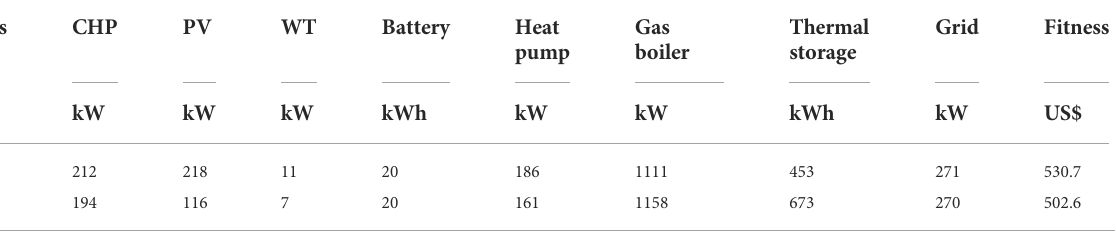
TABLE 5 Optimum con fi gurations of the hybrid system considering various objectives.